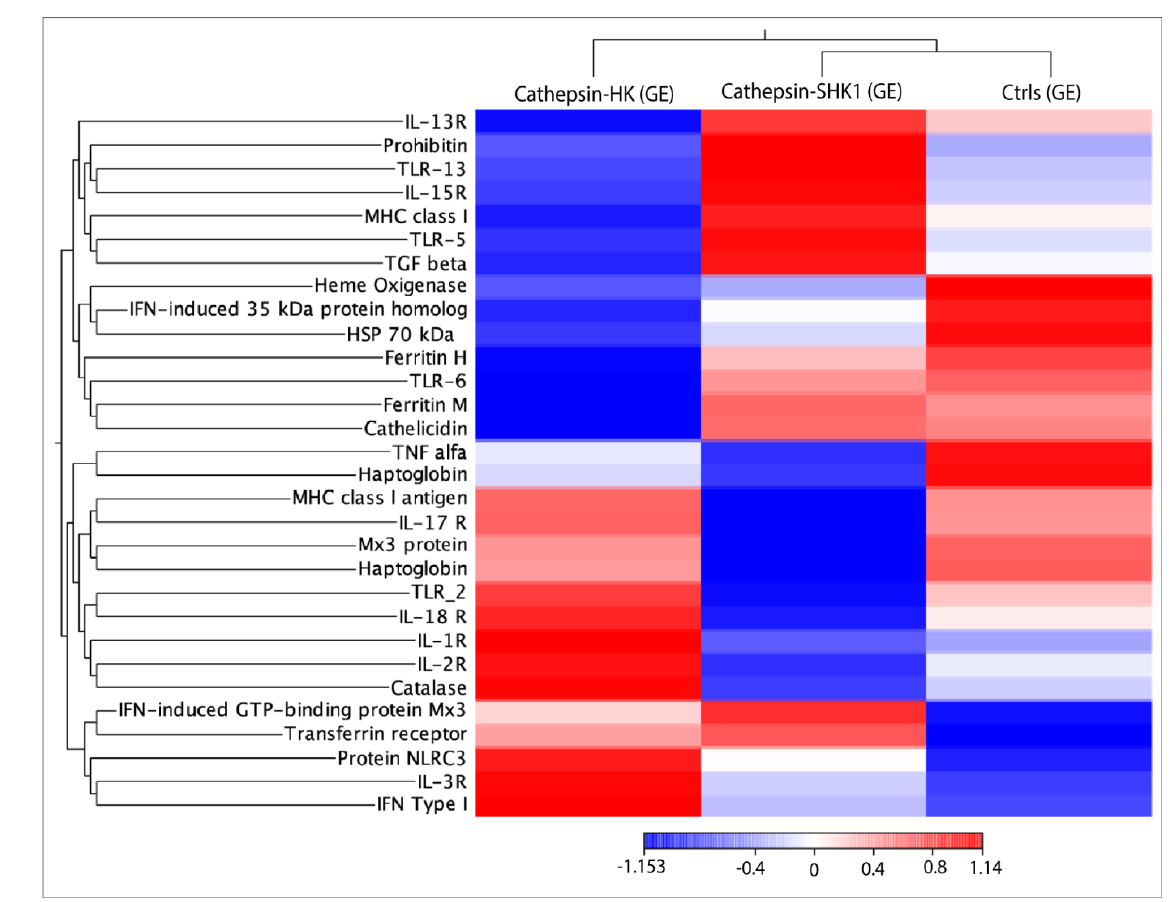
Figure 4. RNA-seq analysis of 30 immune-related genes selected from common DEGs in response to Cr-cathepsin. Heatmaps for each treatment were constructed with the TPM (transcripts per million of reads) values of mRNAs and grouped by hierarchical clustering based on Manhattan distance with average linkages. A red color indicates up-regulated mRNAs, and blue represents down-regulated transcripts.